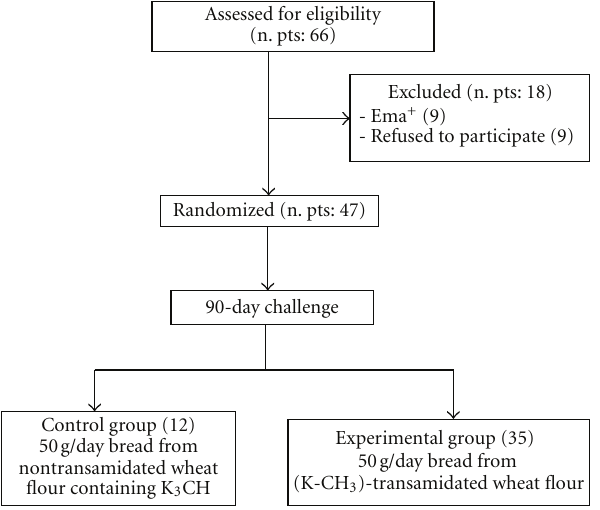
Figure 1: Flow chart of the